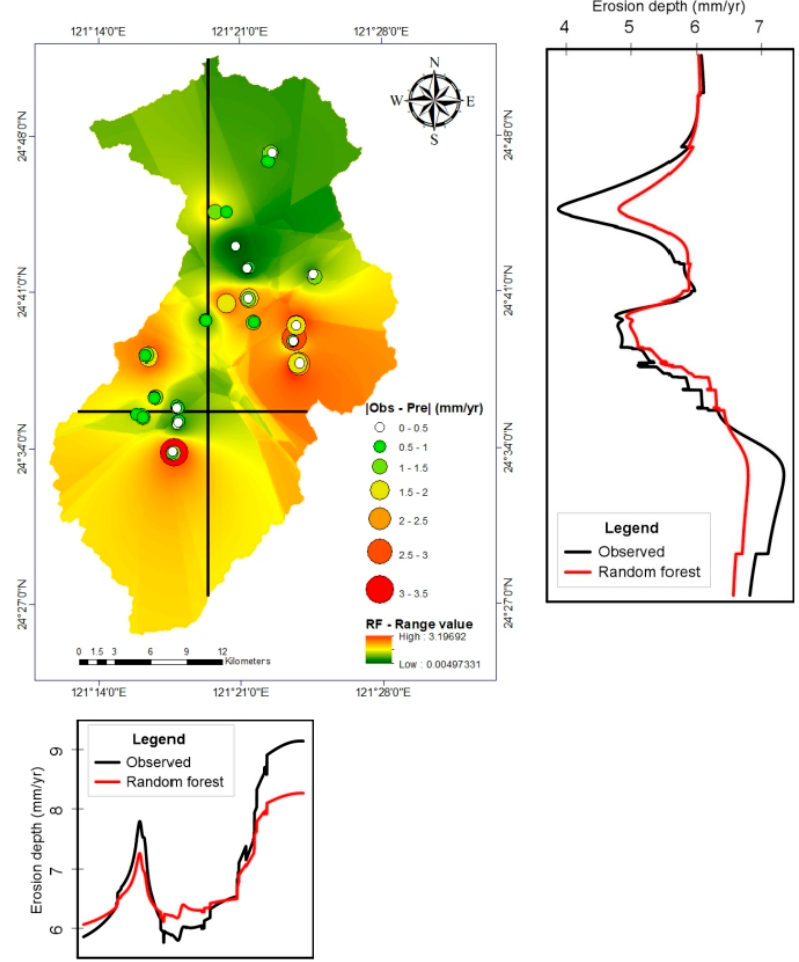
Figure 9. Map and profile of the study area showing the absolute difference between model prediction (RF) and observation (mm/year).